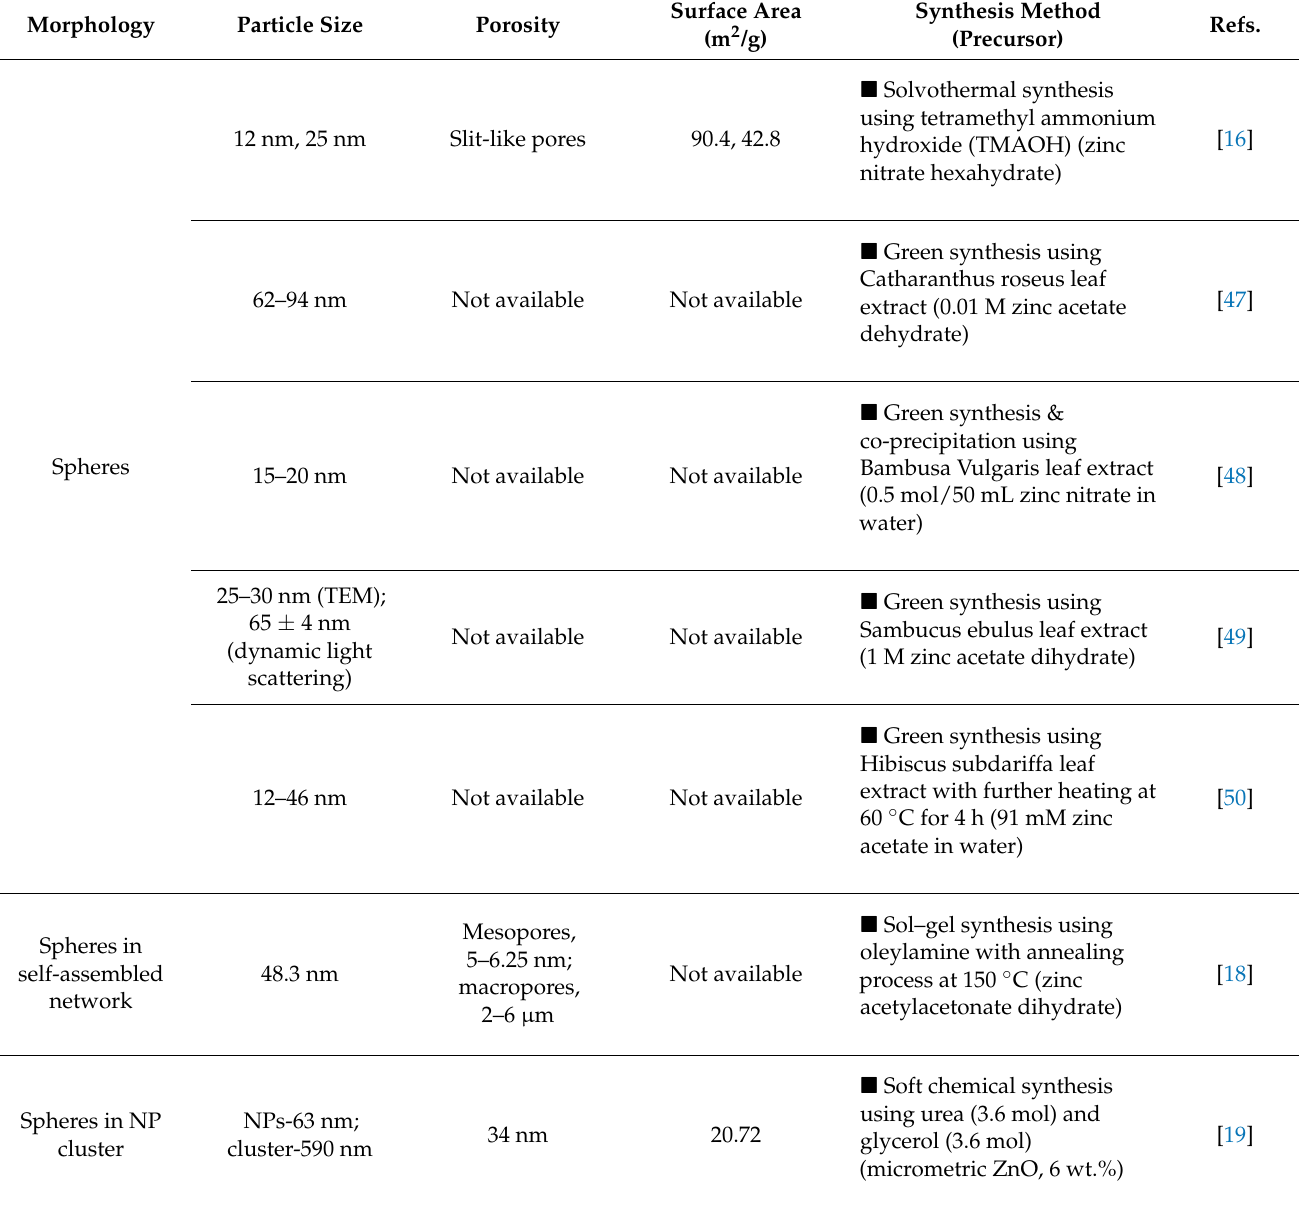
Table 1. Physicochemical characteristics of zinc oxide (ZnO)